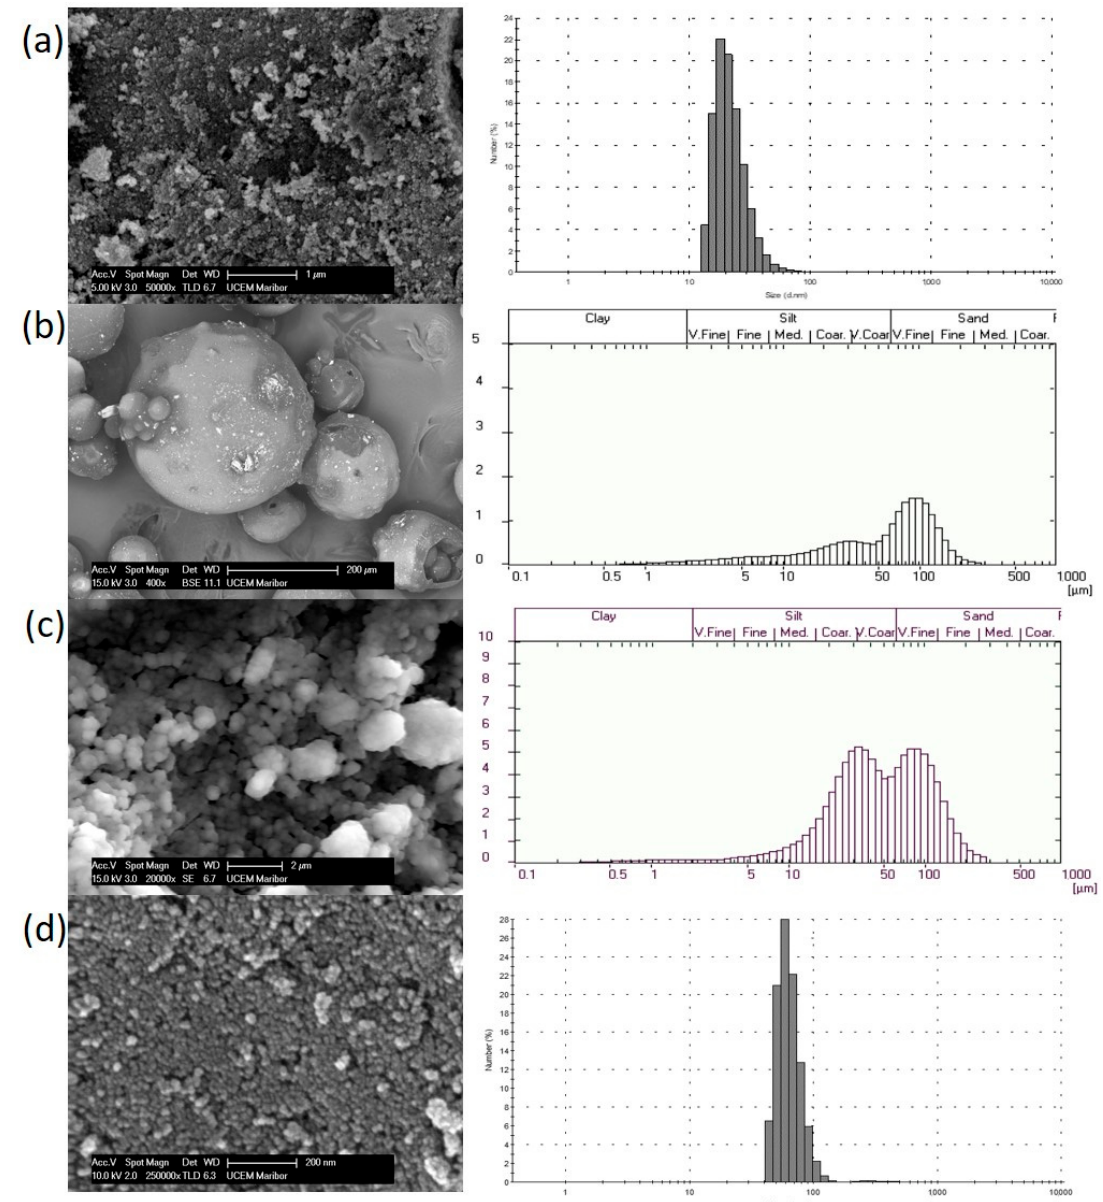
Figure 3. SEM micrographs and particle size distribution of ( a ) bare maghemite, ( b ) magnetic nanoparticles functionalized with chitosan using a microemulsion process (MC1), ( c ) magnetic nanoparticles functionalized with chitosan using a suspension cross-linking process (MC2) and ( d ) magnetic nanoparticles functionalized with chitosan using a covalent binding method (MC3).